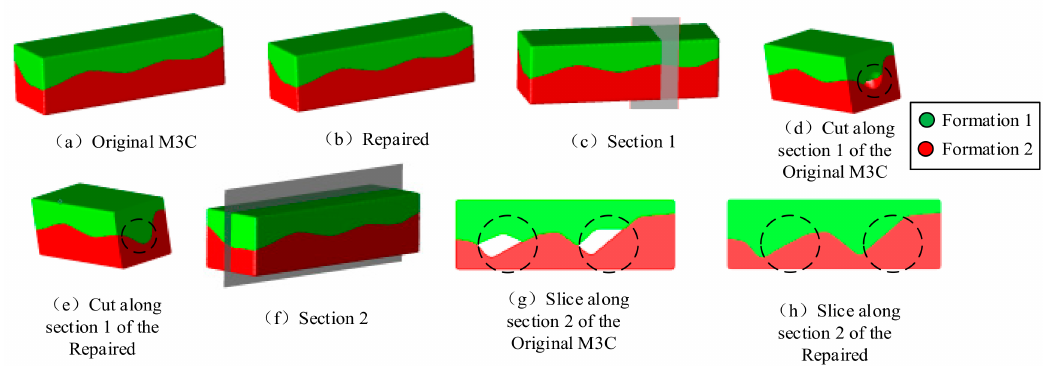
Figure 8. Two-formation geological